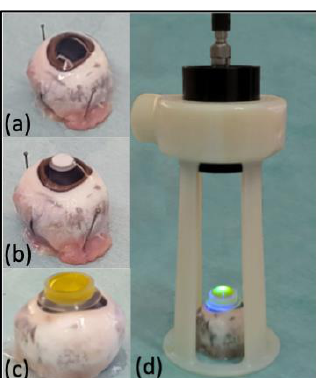
Figure 1. (a) healthy enucleated porcine eyes; (b) porcine eyes showing the filter paper placed on the Figure 1. ( a ) healthy enucleated porcine eyes; ( b ) porcine eyes showing the filter paper placed on the center of the ocular surface; (c) application of isoosmolar 0.1% riboflavin drops into a circular plastic center of the ocular surface; ( c ) application of isoosmolar 0.1% riboflavin drops into a circular plastic for 30 min; (d) details of the UV-A lamp with an irradiance of 30 mW/cm2 during riboflavin/UV-A for 30 min; ( d ) details of the UV-A lamp with an irradiance of 30 mW / cm 2 during riboflavin / UV-A corneal phototherapy. corneal